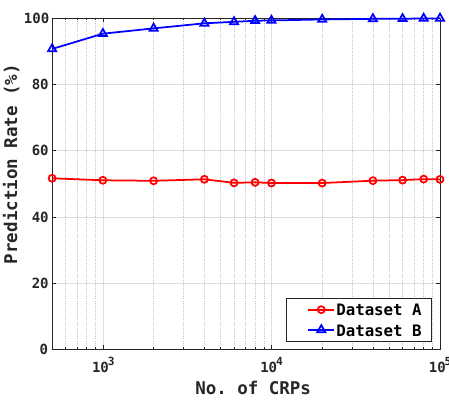
Figure 5. The prediction rates of LR attack on a 64-bit XMPUF designs using different feature vectors.